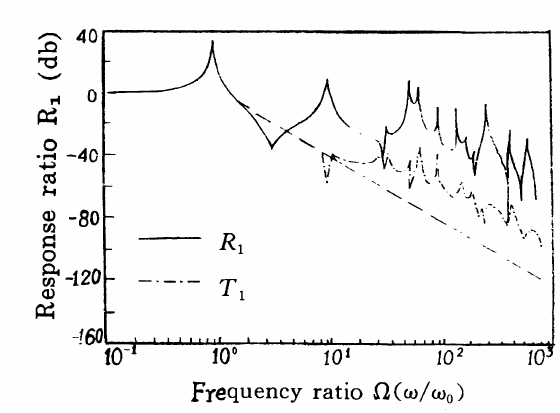
FlGURE 3 Comparison of RI and T I: 'YI = 100, 'Y/ = 0.05, 8 = 0.01, A = 10, M1Mb =